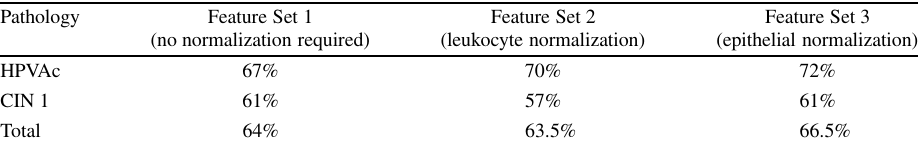
Cells-by-cells analysis: Results of the stepwise discriminant analysis of koilocytosis and CIN 1 lesions using the three features sets. F -to-enter, F -to-removed: